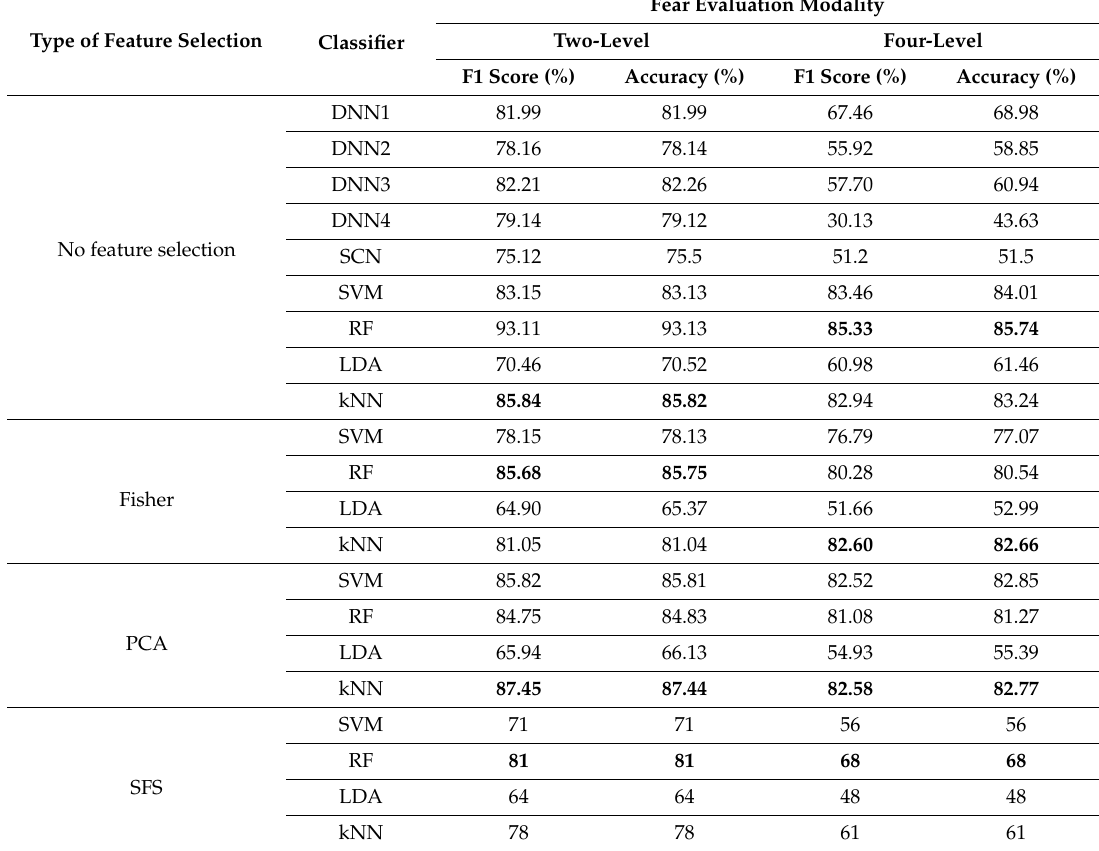
Table 4. Classification accuracy when input is a vector of 30 alpha, beta and theta PSDs and eight peripheral signals. (The highest accuracies are written with bold.)